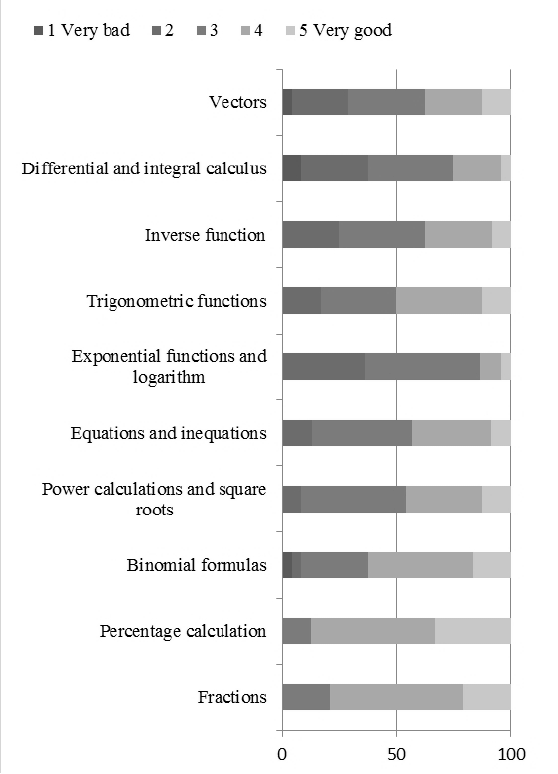
Figure 10. Command of mathematical topics at the end of the course ratory course selects the really interested people. In that sense it can be regarded as an effective